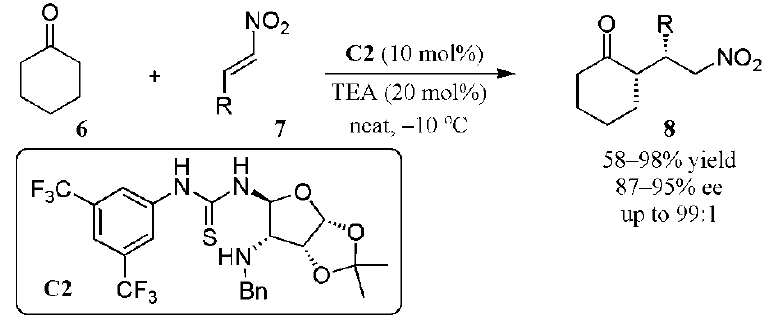
Figure 7. Michael addition reaction catalyzed by C2 [31].